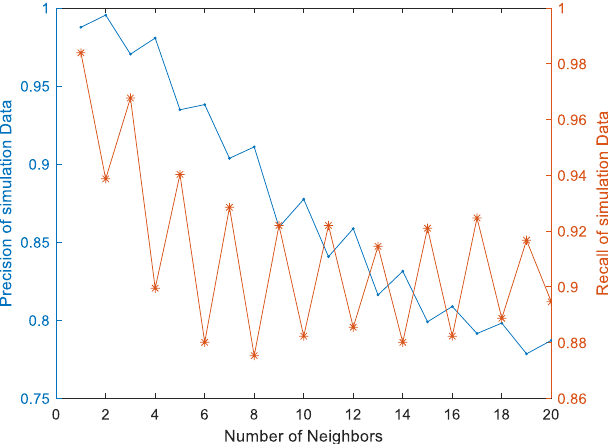
Figure 8. Number of neighbors vs. precision (in blue) and recall (in red) of simulation data.